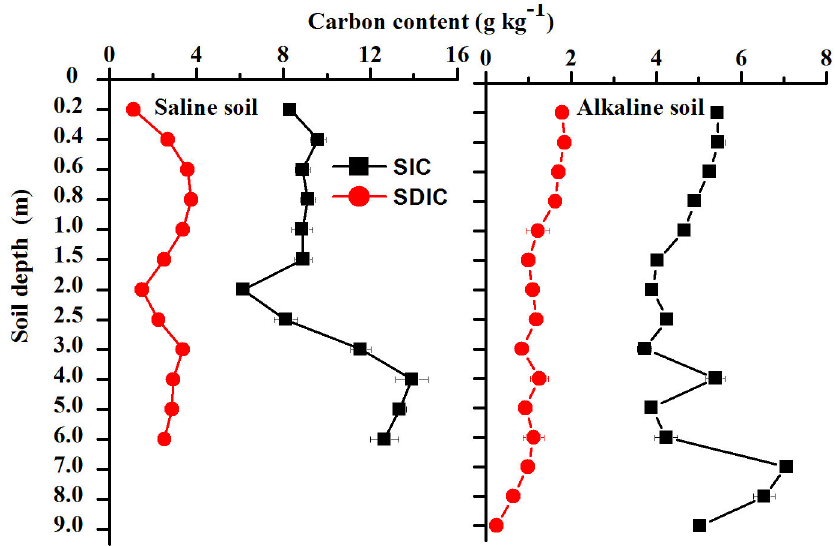
Figure 2. Mean SIC and SDIC content and standard error in the saline and alkaline soil profiles.